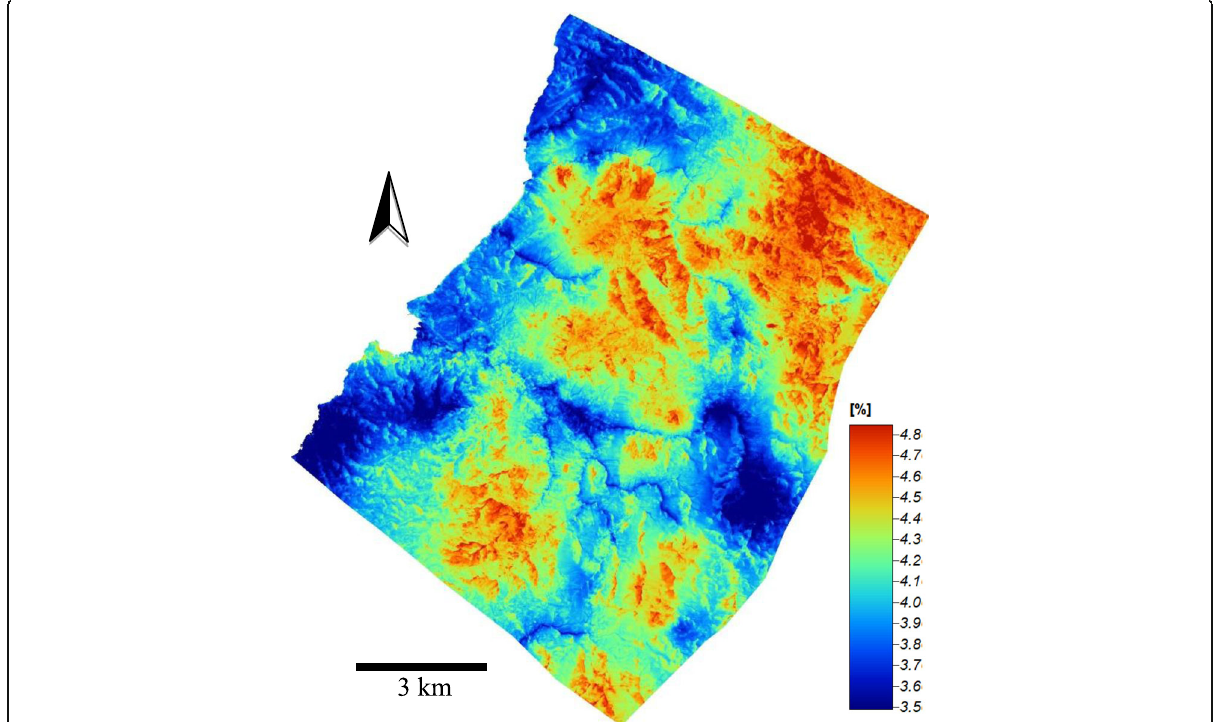
Fig. 7 Final Model of Transformed Clay by UK with predictors by backward elimination method and exponential variogram